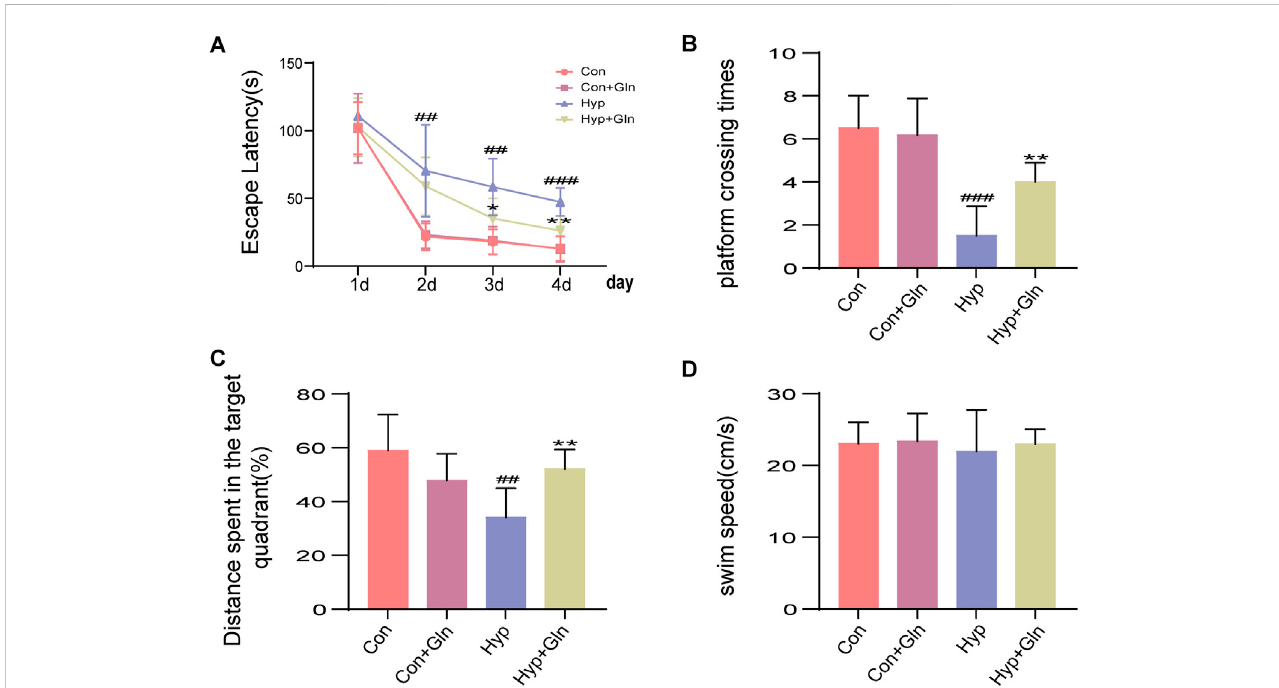
FIGURE 9 Gln ameliorates distant neurobehavioral de fi cits in rats with hyperoxia-induced brain injury. (A) Latency to escape in MWM. Con (101.96 ± 7.86, 21.63 ± 4.05, 18.07 ± 3.71, 12.94 ± 3.68), Con + Gln (101.76 ± 10.43, 23.10 ± 4.09, 18.85 ± 4.16, 12.66 ± 3.85), Hyp (110.78 ± 4.19, 70.39 ± 13.85, 58.48 ± 8.53, 47.28 ± 4.24),Hyp+Gln(102.54±8.82,58.89±8.76,35.25±5.99,26.22±4.50). (B) TimescrossingplatforminMWM.Con(6.50±0.62),Con+Gln(6.17±0.70),Hyp (1.50 ± 0.56), Hyp + Gln (4.00 ± 0.37). (C) Distance spend in the target quarter in MWM. Con (58.97 ± 5.46), Con + Gln (47.82 ± 4.06), Hyp (34.12 ± 4.42), Hyp+Gln(52.19±2.92). (D) SwimspeedinMWM.Con(23.04±1.22),Con+Gln(23.39±1.58),Hyp(21.95±2.37),Hyp+Gln(22.96±0.86)( n =6). ## p < 0.01,